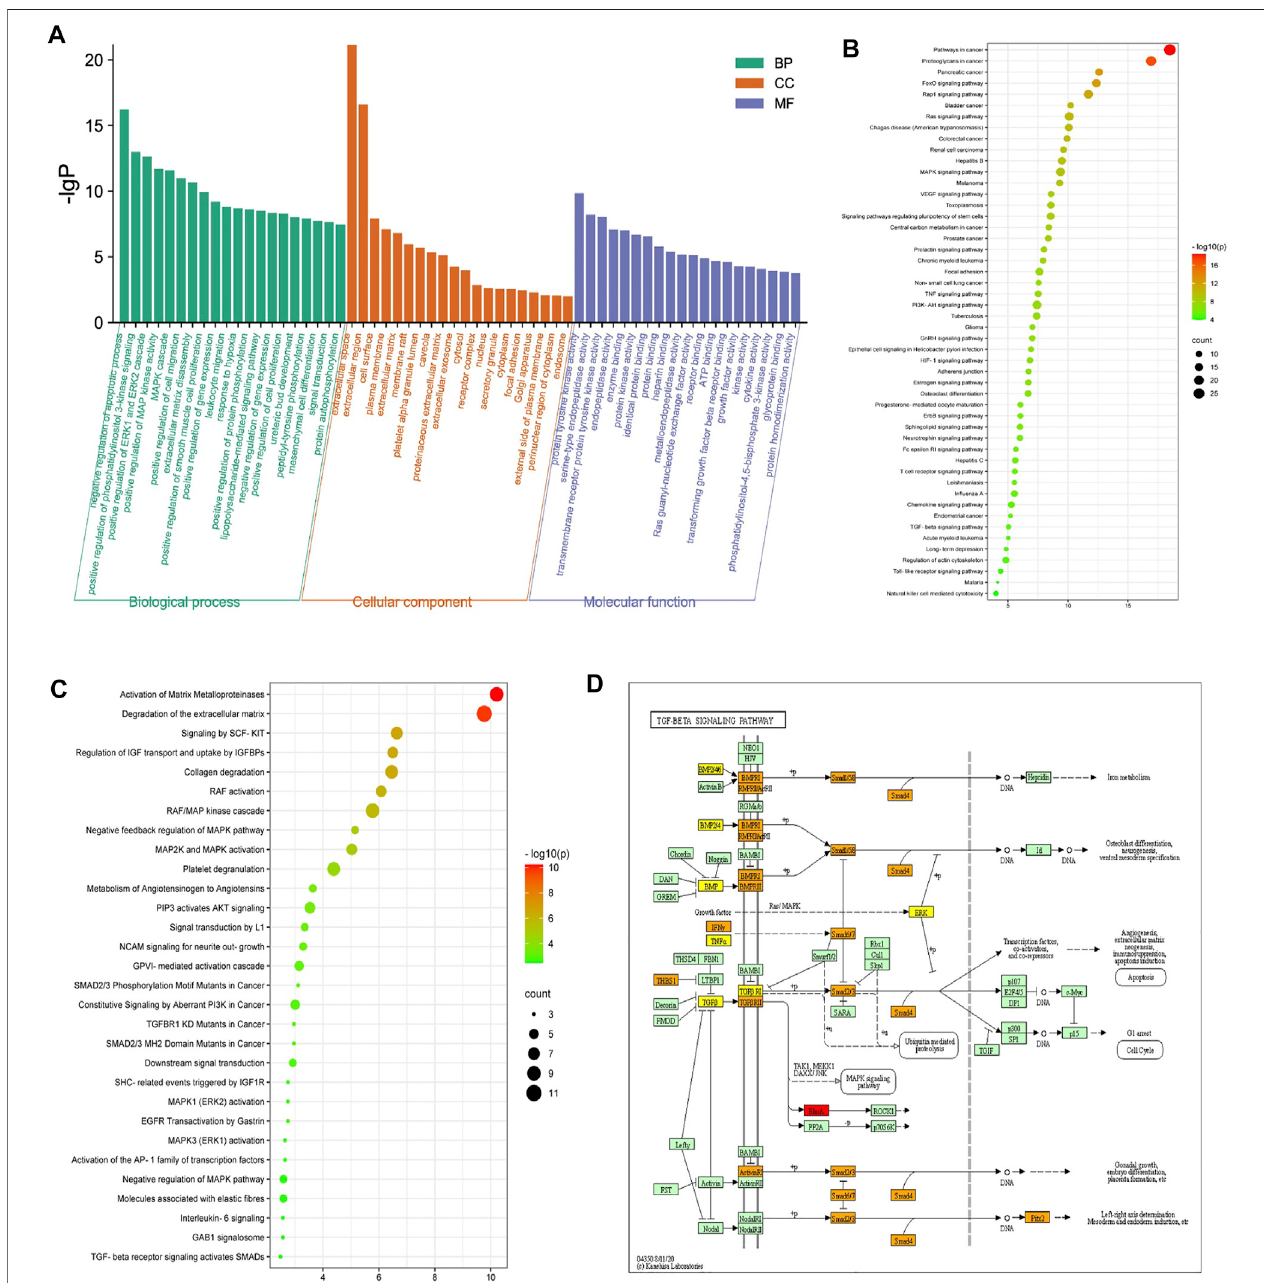
FIGURE3| EnrichmentanalysisofthepotentialtargetsofQMagainstPFwasconductedbasedontheDAVIDdatabase. (A) Top20biologicalprocess(BP)terms, cellular component (CC) terms, and molecular function (MF) terms are shown as a bar diagram, according to the -lg p value. (B,C) The top 50 entries of KEGG pathway analysisandthetop30entriesoftheReactomepathwayanalysiswereselectedandorderedaccordingtothe-lgpvalue. (D) TheTGF- β signalingpathwaymodi fi edfrom hsa04350. Red represents targets of QM, orange represents key targets participated in PF, and yellow represents overlapping targets between QM and PF.